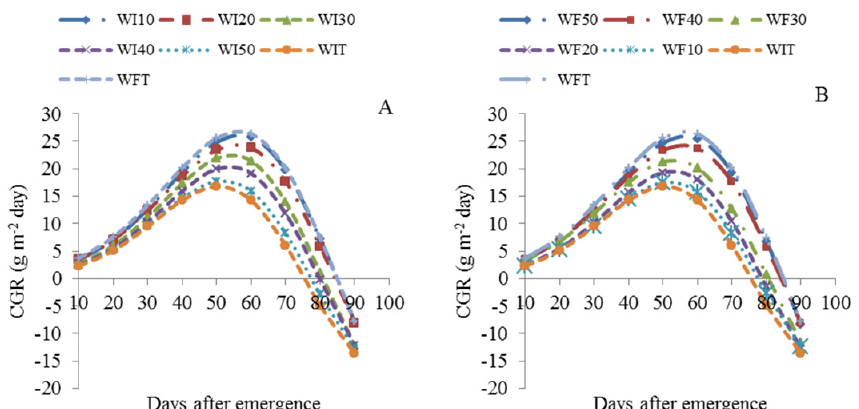
Fig. 2. Effect of increase in duration of weed interference (A) and weed free periods (B) on crop growth rate (CGR) of dry bean. WI , WI , WI , WI and WI : weed infested peri- 10 20 30 40 50 ods until 10, 20, 30, 40 and 50 days after crop emergence, respectively; WF , WF , WF , 10 20 30 WF and WF : weed free periods until 10, 20, 30, 40 and 50 days after crop emergence, 40 50 respectively; WI and WF : weed competition and weed control throughout growing sea- T T son, respectively